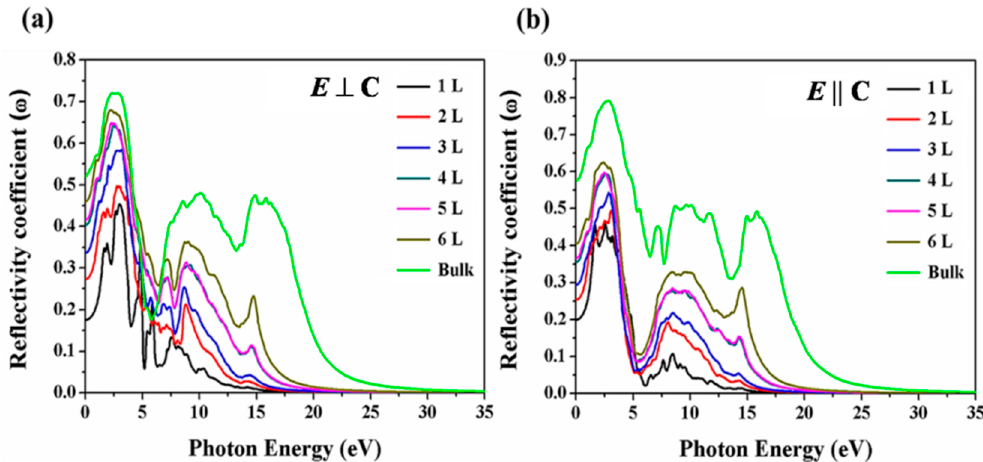
Figure 6. Calculated reflectivity coefficient along ( a ) Ε ⊥ C and ( b ) Ε || C polarization directions of the few-layer Te and bulk Tellerium.